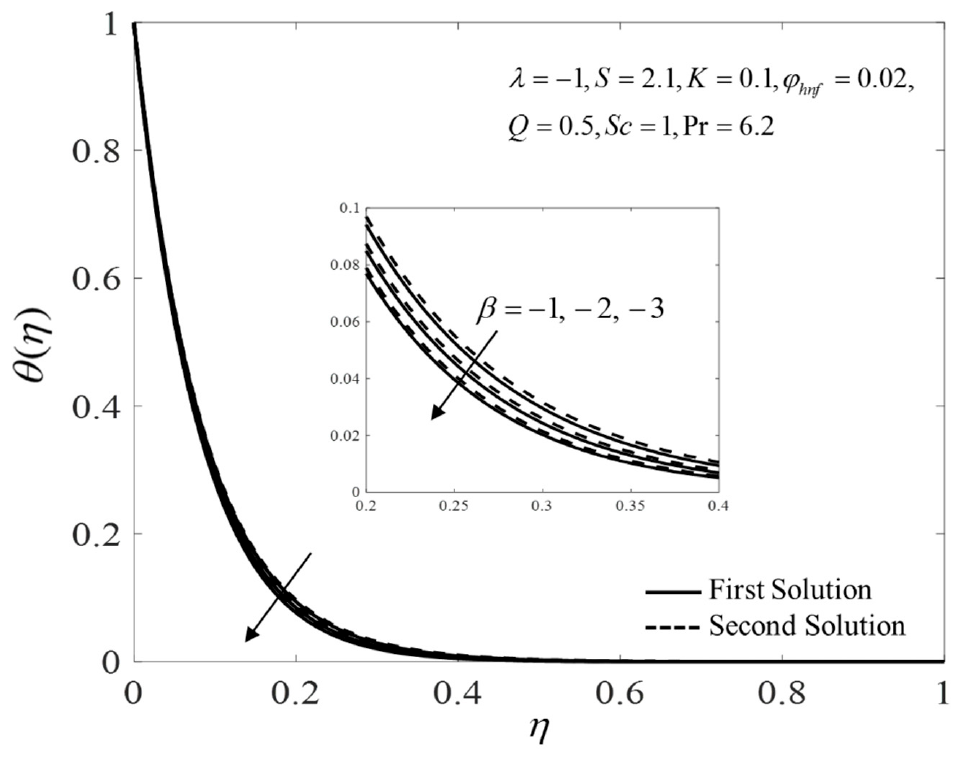
Figure 5. Plot of ( ) f  for several values of  .